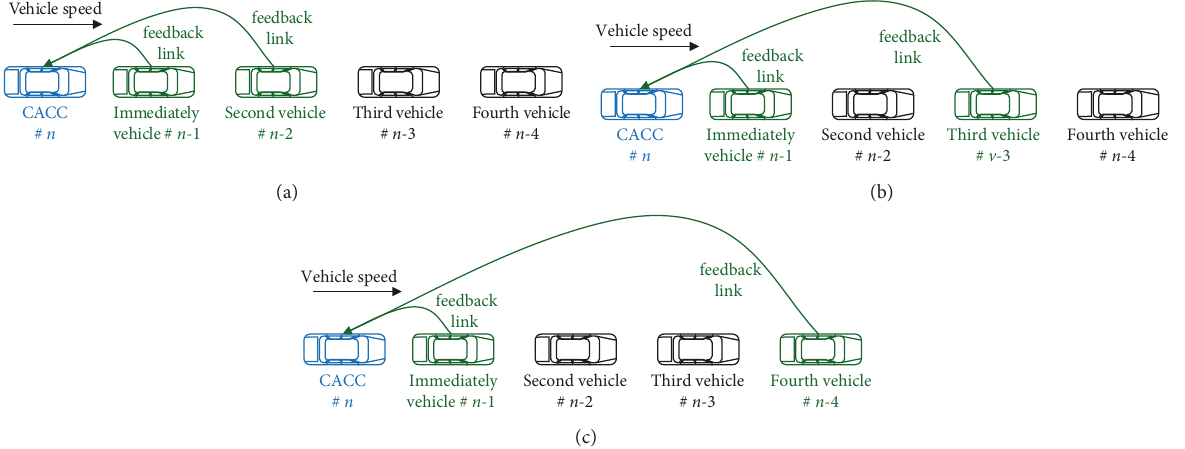
Figure 1: CACC feedback link types studied as the objective of this paper. (a) Link type I. (b) Link type II. (c) Link type